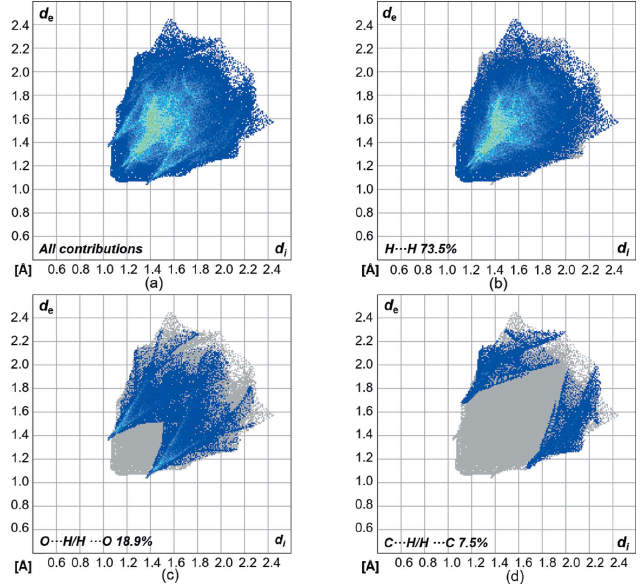
Figure 6 The crystal packing of compound 2 in a partial view along the b axis. C—